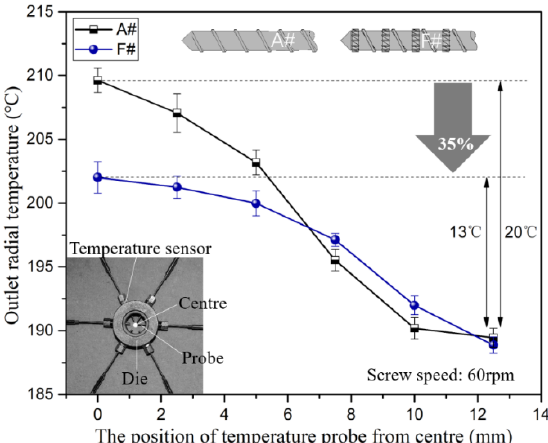
Figure 7. Outlet radial temperature distribution in the extrusion die.